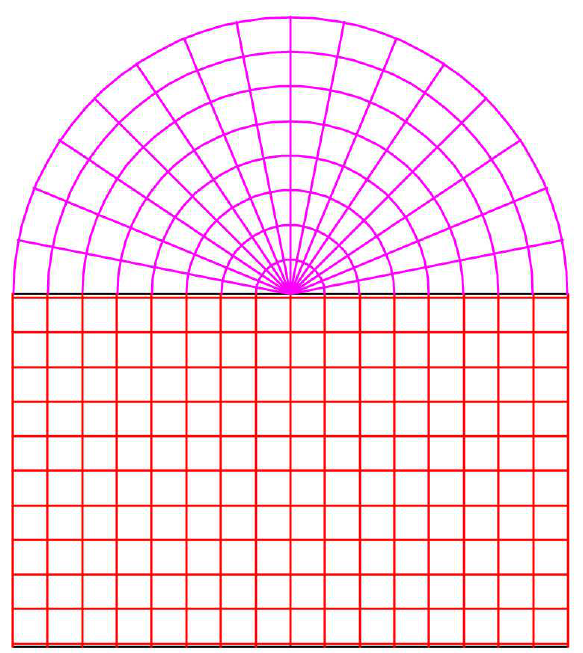
Figure 9. Unfolding of the apse with the cylindrical surface and spherical basin.